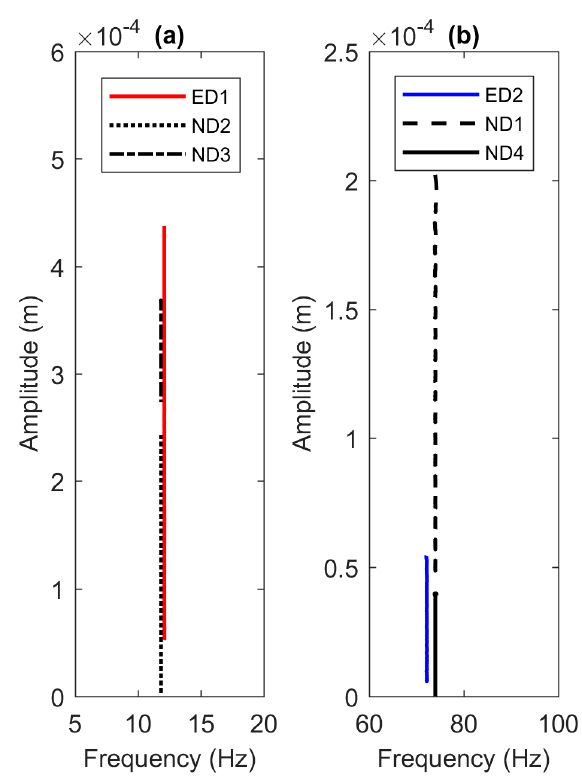
Figure 6. The decomposed signals of the ( a ) experiment data and ( b ) numerical data.